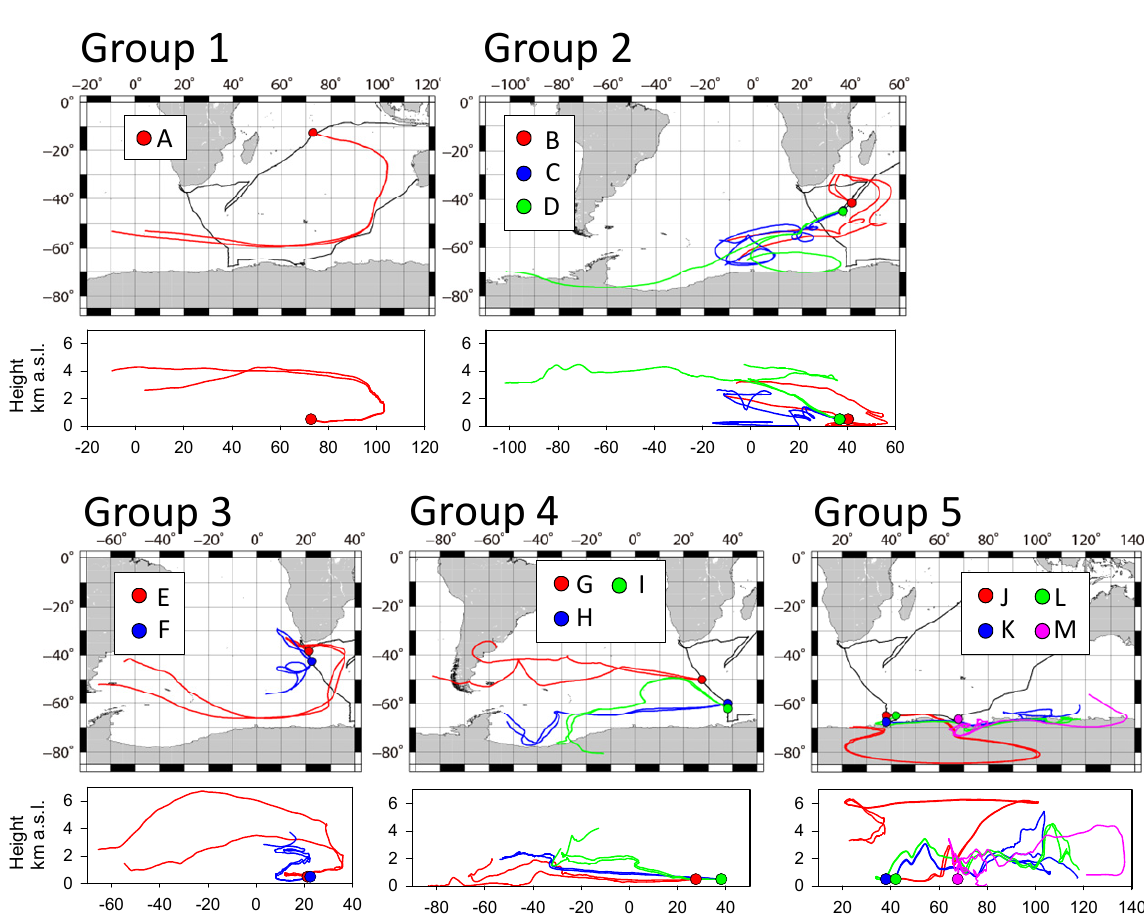
Figure 8. TEM sampling location A–M and the 10-day backward trajectories for air masses reaching the location at 500ma.s.l. during sampling periods. Black lines show the ship track. Colored (red, blue, green, and pink) circles and lines respectively represent sampling locations and backward